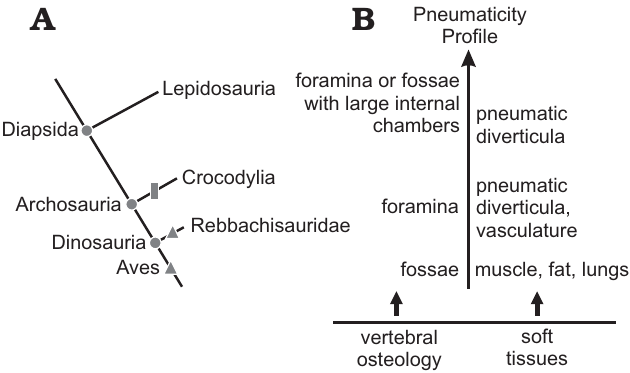
Fig. 1. A . Simplified phylogeny of Diapsida showing position of Rebbachi- sauridae and both components of the rebbachisaurid Extant Phylogenetic Bracket sensu Witmer 1995 (Crocodylia and Aves). Rectangle indicates absence of postcranial pneumaticity; triangles indicate presence of post- cranial pneumaticity. B . Hypothesized osteological correlates of pneu- matic and other soft tissue structures in archosaurian vertebrae (based on O’Connor